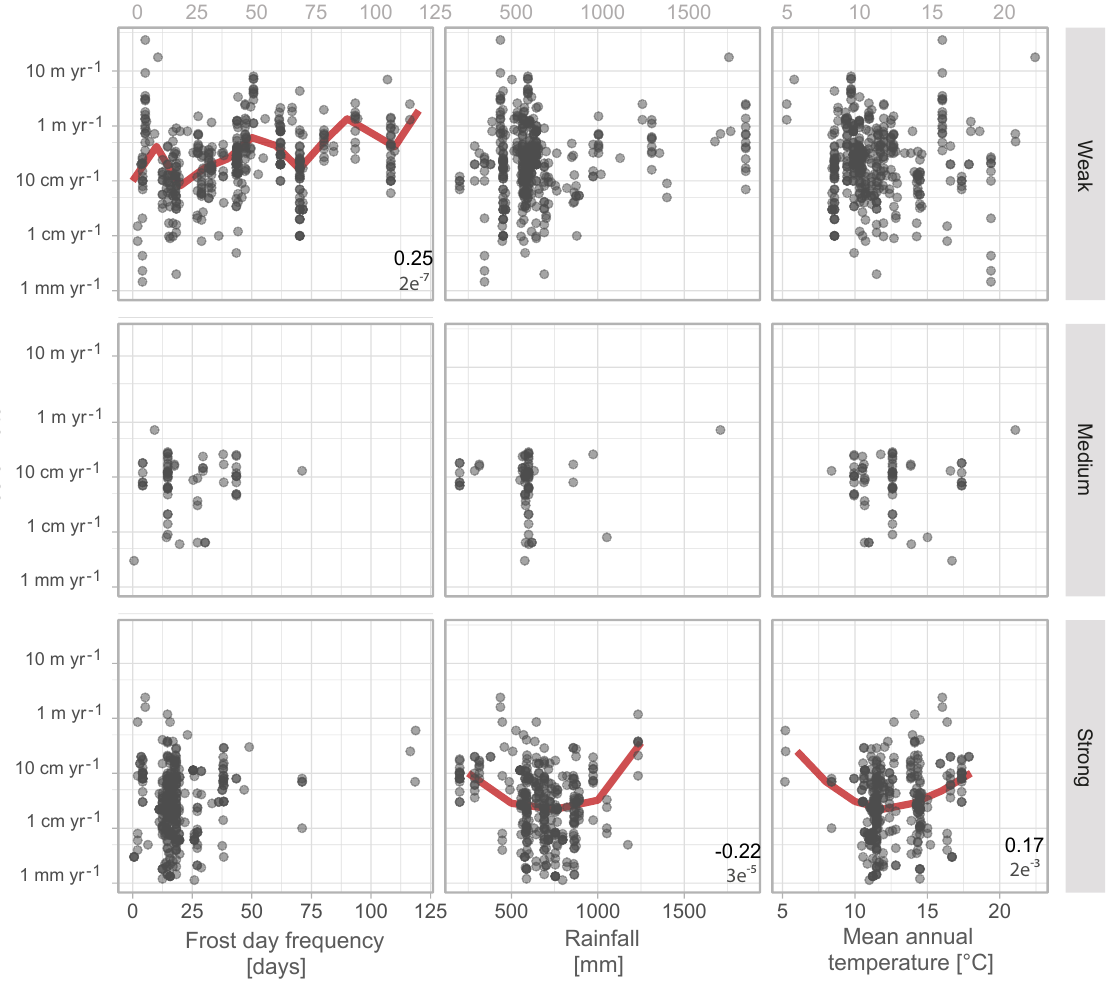
Figure 9. Erosion rate versus climate forcings (frost day frequency (days), annual cumulated rainfall and (mm) mean annual temperature ( ◦ C)) for each of the Hoek and Brown rock resistance class. The overprinted lines on the scatterplots represent moving median, and the numbers are the Spearman rank correlation coefficients, which were only reported when the p value was significant ( > 2 e − 2